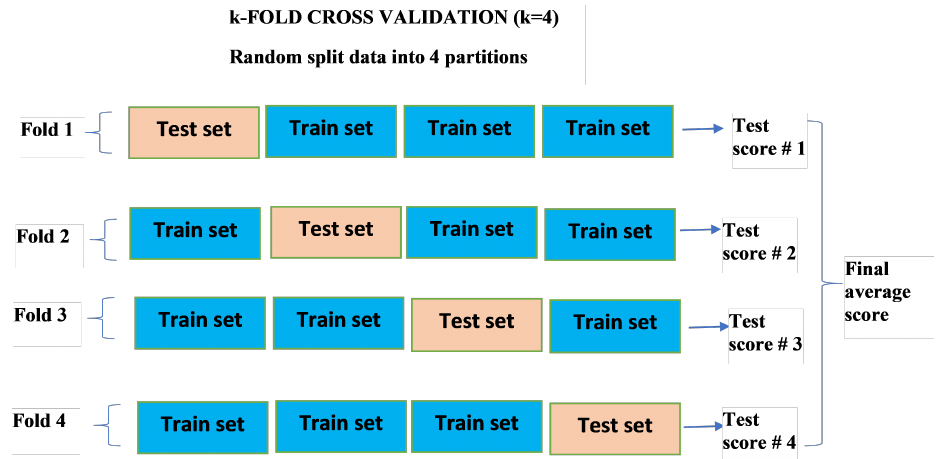
Figure 5. k-fold cross validation. The available data is split into 4 random partitions where each fold has three train sets and one set for evaluating the model. The RMSE is used to score each outcome from training each fold. The final average score is computed from each test score. The standard deviation is also